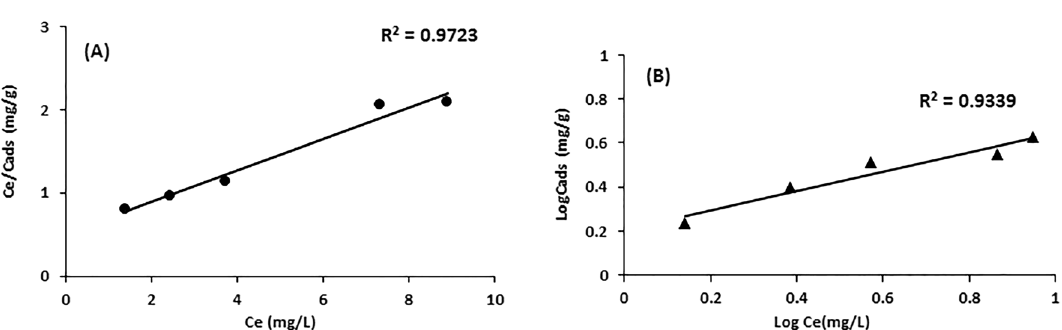
Figure 3. FTIR frequencies of hydrochar ( a ), activated hydrochar ( b ) and Cd-adsorbed activated hydrochar ( c ).